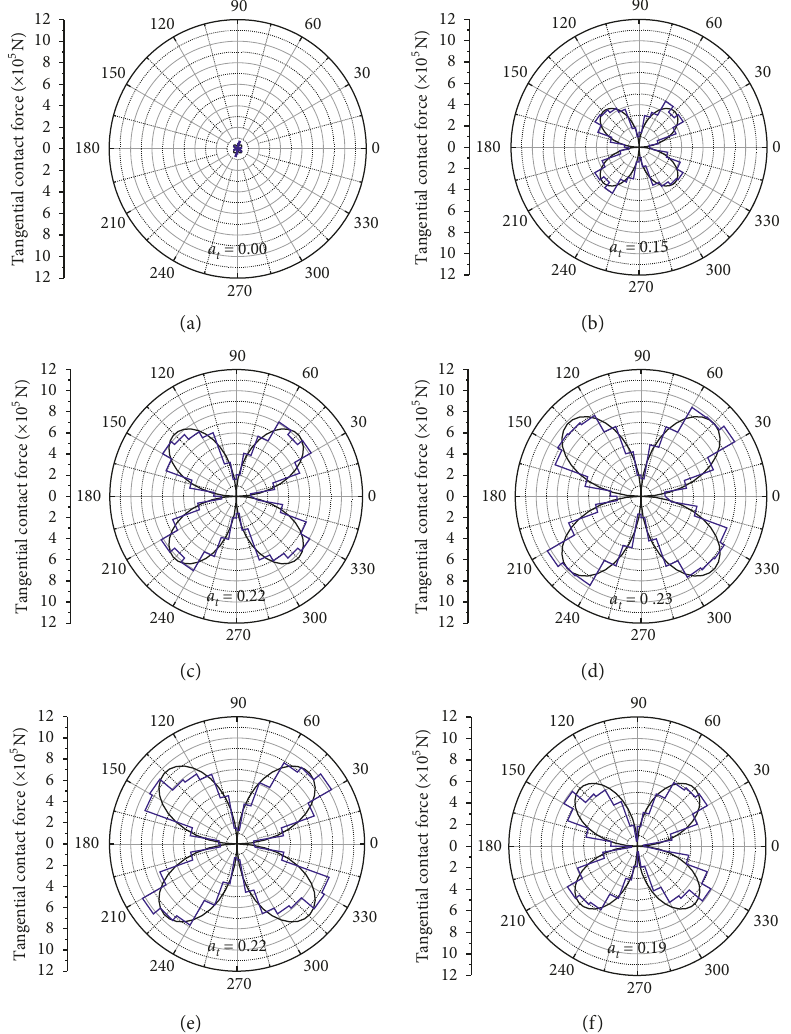
Figure 11: Evolution of anisotropy in tangential forces during shearing: (a) ε ε a �